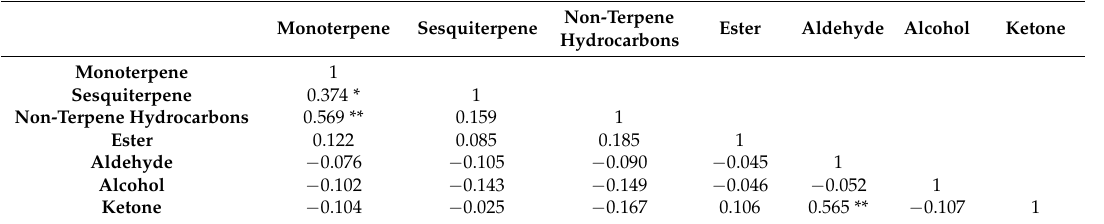
Table 8. Linear correlation coefficients among different classes of volatile compounds. Non-Terpene Monoterpene Sesquiterpene Ester Aldehyde Alcohol Ketone Hydrocarbons Monoterpene 1 Sesquiterpene 0.374 * 1 Non-Terpene Hydrocarbons 0.569 ** 0.159 1 Ester 0.122 0.085 0.185 1 Aldehyde − 0.076 − 0.105 − 0.090 − 0.045 1 Alcohol − 0.102 − 0.143 − 0.149 − 0.046 − 0.052 1 Ketone − 0.104 − 0.025 − 0.167 0.106 0.565 ** − 0.107